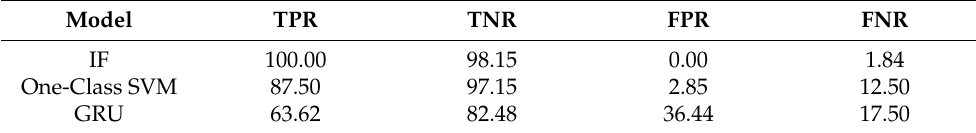
Table 3. Anomaly detection performance metrics for the best methods.